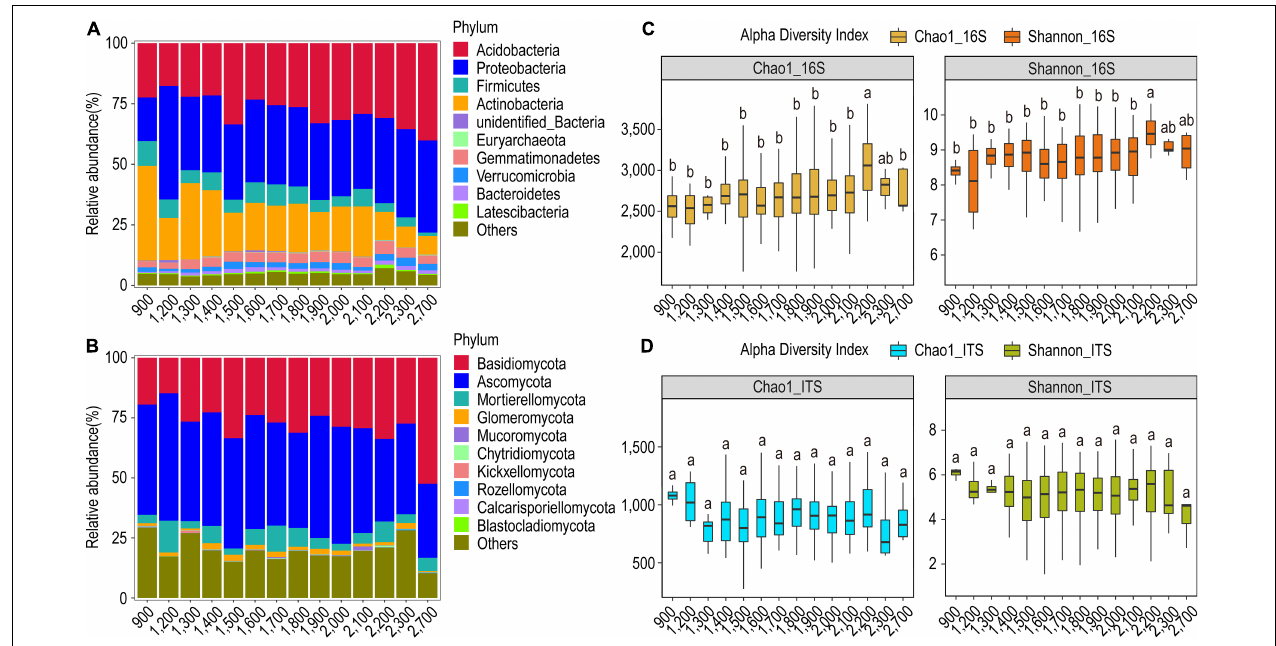
FIGURE 3 | Relative abundance and α -diversity indices of soil bacterial and fungal communities in different altitude groups. (A) Relative abundance of bacteria at the phylum classification level; (B) relative abundance of fungi at the phylum classification level; (C) Chao1 and Shannon indices of bacteria and fungi. (D) Different lowercase letters indicate significant differences between subgroups ( p < 0 .